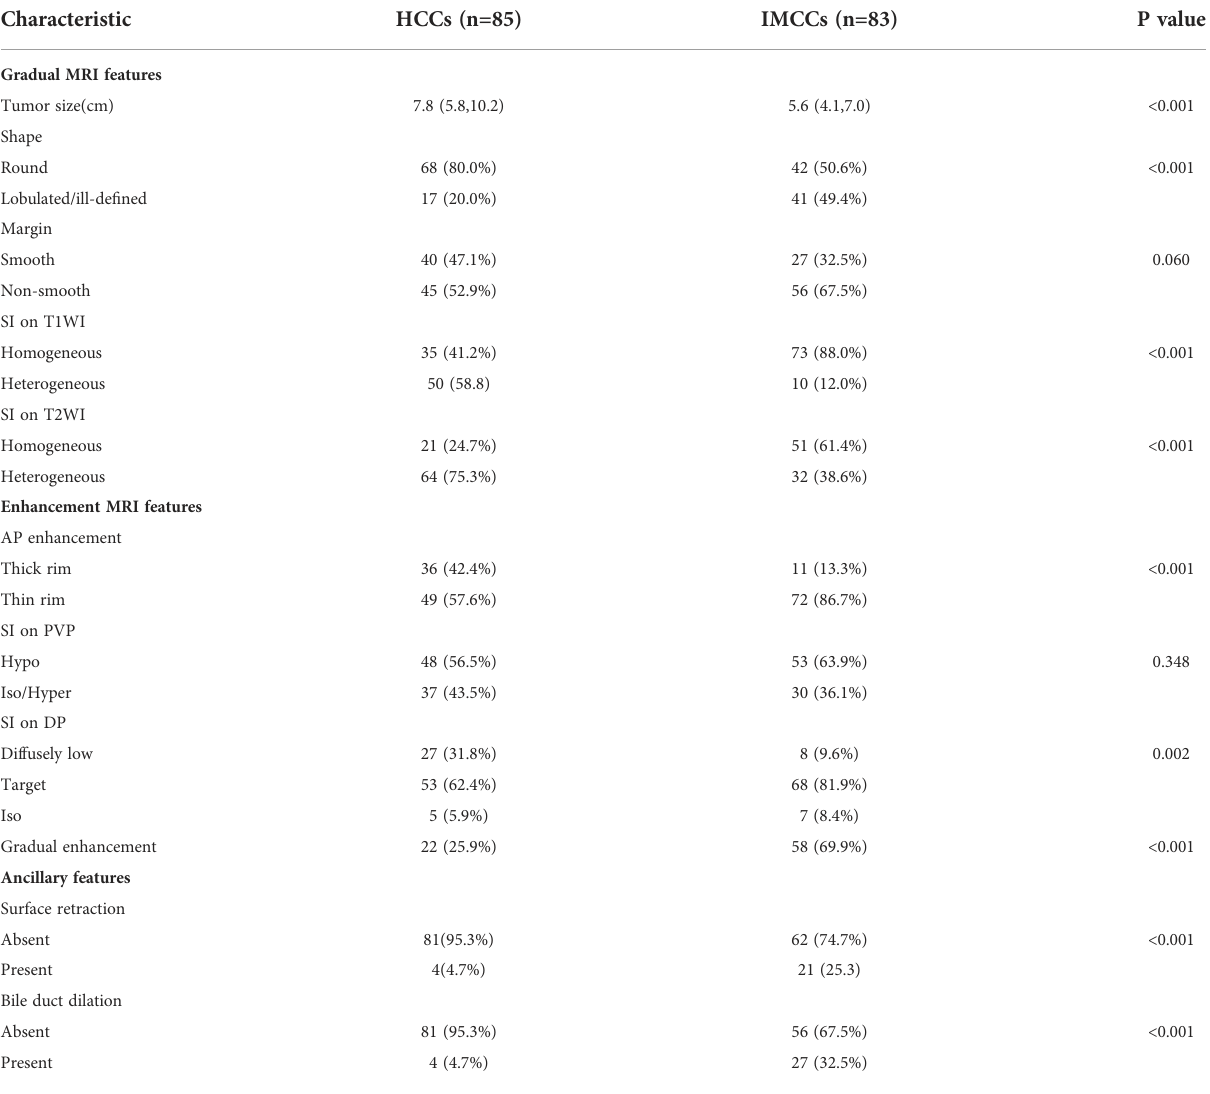
TABLE 2 MRI characteristics of HCCs and